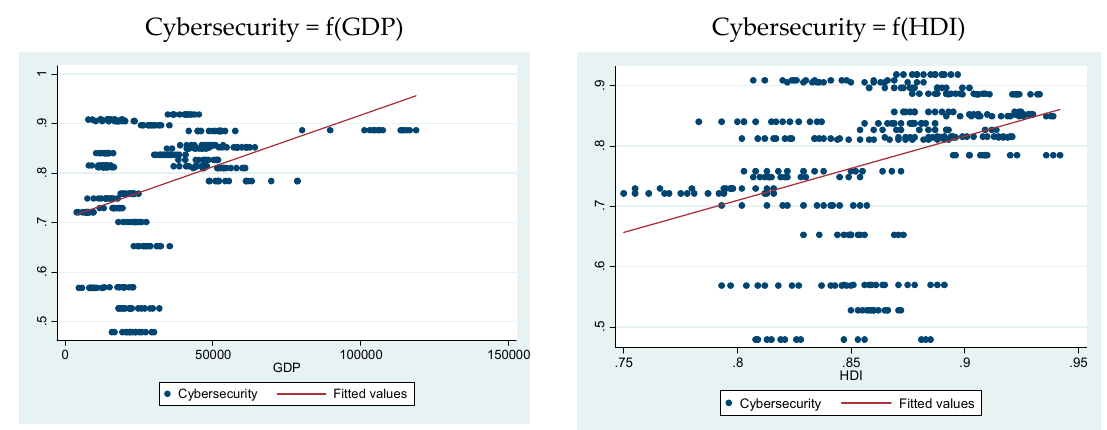
Figure 7. Financial and economic crime proxies as a function of economic and sustainable development. Source: Authors’ procedure in Stata.